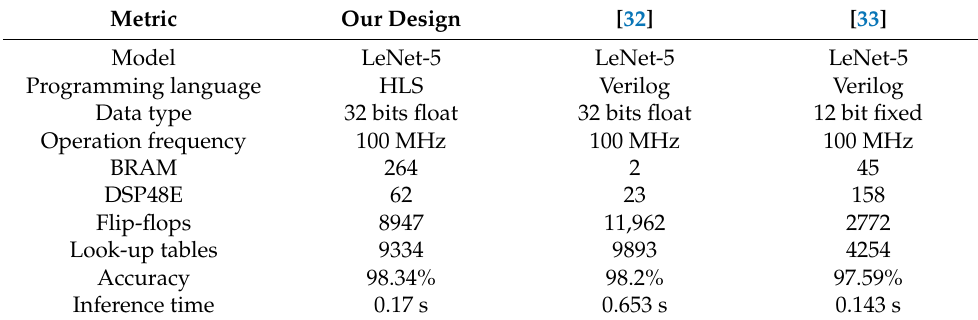
Table 6. The comparison with some